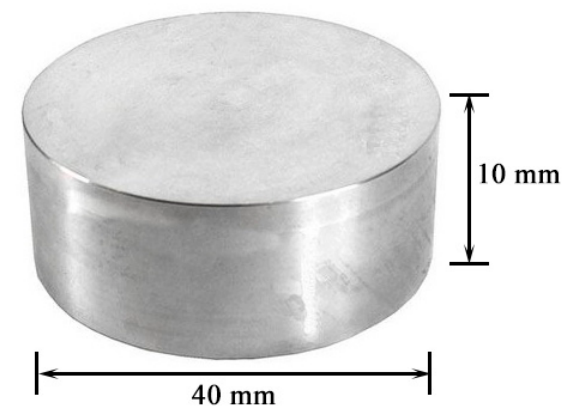
Figure 1. Powder metallurgy-produced ODS